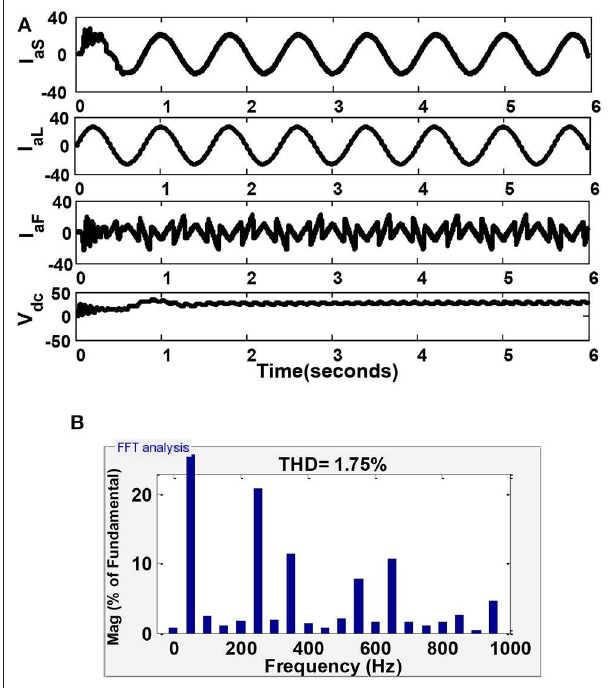
FIGURE 6 | Power quality analysis in the three-phase system using the RLS algorithm under balanced load conditions: (A) simulation results showing supply current, load current, filter voltage, and DC-bus voltage; and (B) THD value of 1.78%.